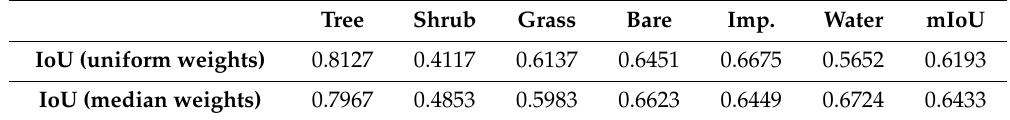
Table 16. IoU (uniform and median weights, Oregon—6 classes). Tree